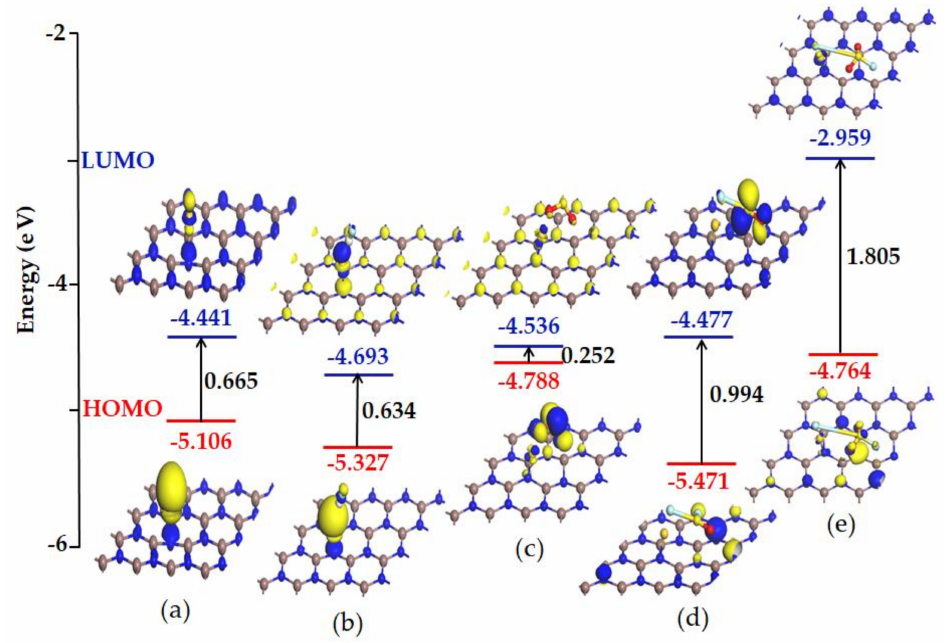
Figure 6. HOMO and LUMO of ( a ) Au-InN monolayer and ( b ) Au-InN/HF, ( c ) Au-InN/SO 2 , ( d ) Au-InN/SOF 2 , ( e ) Au-InN/SO 2 F 2